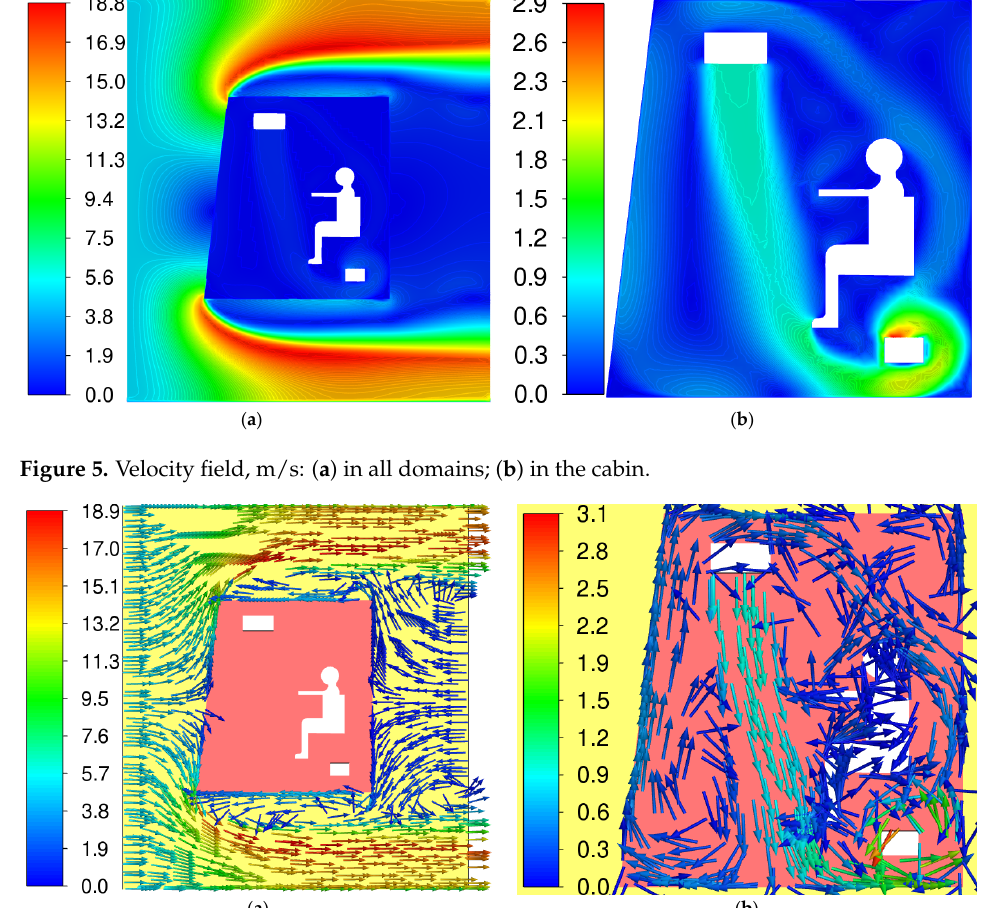
( b ) Figure 7. Temperature, °C: ( a ) in the cabin; ( b ) in all domains. Figures 8–13 show the values of heat transfer coefficients from Equations (14) and (15) and heat fluxes on the walls, obtained numerically. It can be noted that the profiles of the heat transfer coefficients determined the air velocity profiles near the inner and outer walls, according to Equations (11)–(13). In particular, the values of the heat transfer coefficients had large gradients at the edges, where the velocity profiles changed direction.